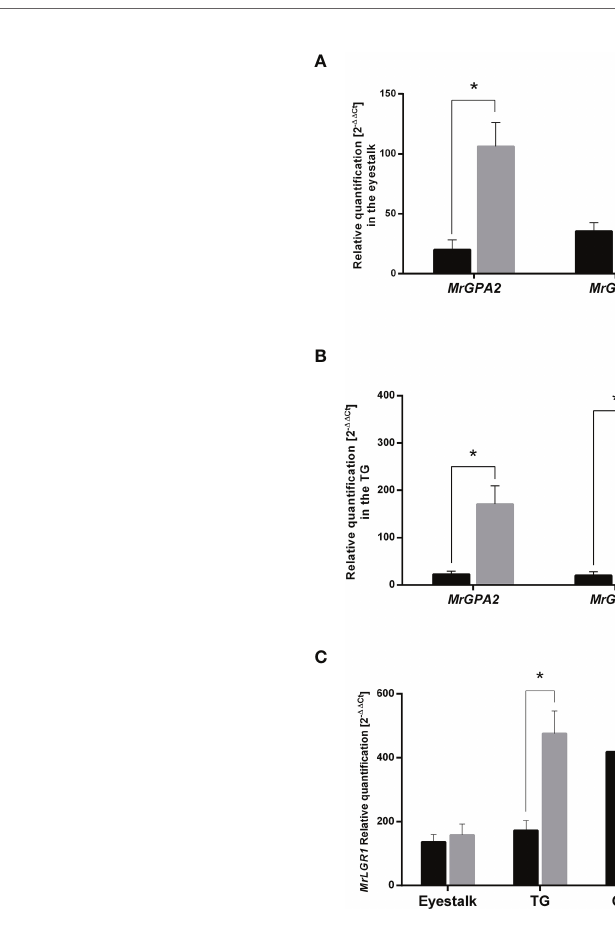
FIGURE 5 | Short-term loss of function through RNAi. Relative quanti fi cation of MrGPA2 and MrGPB5 in (A) the eyestalk and (B) the thoracic ganglia (TG) of M. rosenbergii females injected with mix of ds MrGPA2 and ds MrGPB5 (n = 10) or with dsGFP (control; n = 9). (C) Relative quanti fi cation of MrLGR1 in the eyestalk, TG, ovary and hepatopancreas of females injected with ds MrLGR1 (n = 9) or with dsGFP. Error bars represent standard error of the means. Asterisks indicate statistically signi fi cant differences ( P < 0.05, t